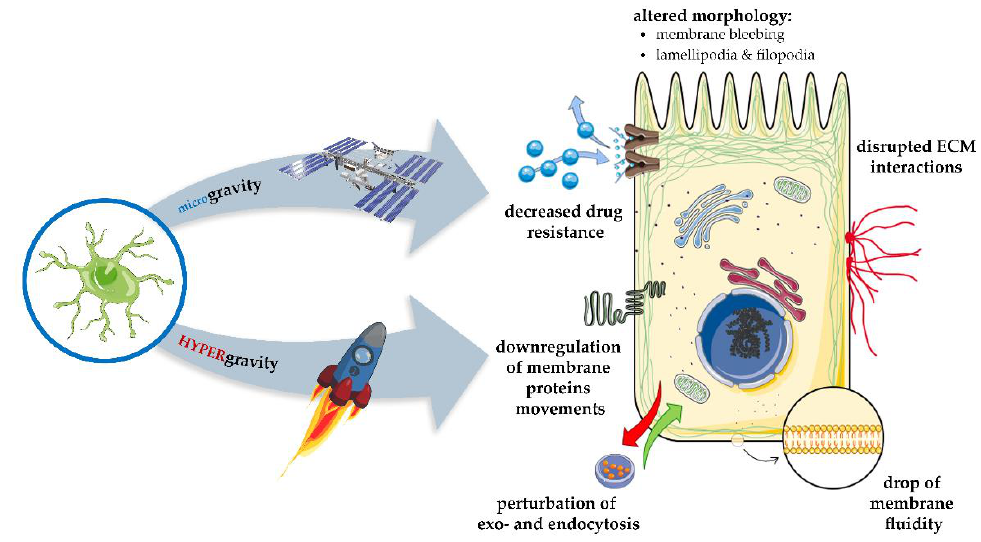
Figure 5. Modification of cell membrane by micro- and hyper-gravity. Altered gravity is known to affect biomembranes on many levels. First, it influences on the morphology of cell by creating membrane blebbing and affects functioning of lamellipodia and filopodia. Furthermore, unnatural gravity alter membrane fluidity and movements of transmembrane proteins leading to decreased multidrug resistance and disruption of exo- and endo-cytosis. This figure was prepared using Servier Medical Art, available from www.servier.com/Powerpoint-image-bank.